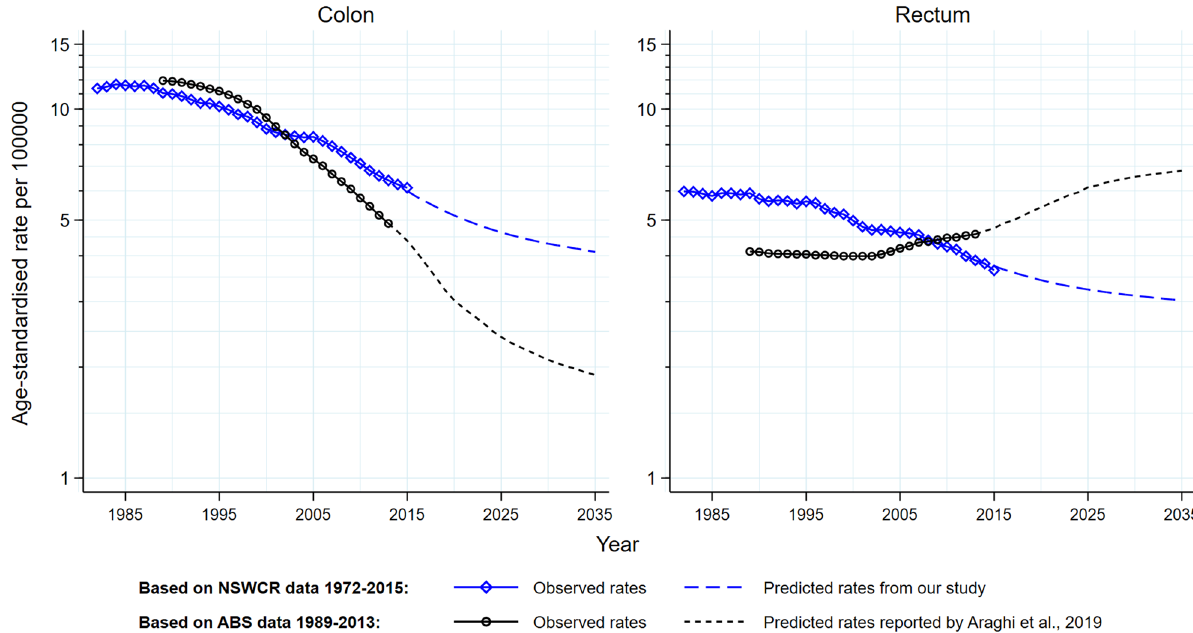
Figure 4. Comparison of projected age-standardised mortality rates published by Araghi et al. 2 , with the results from this study and observed rates based on data from the NSWCR for colon and rectal cancers, males and females combined. All rates are age-standardised using the Segi World standard population. NSWCR: New South Wales Cancer Registry. ABS: Australian Bureau of Statistics. Age-standardised rates from Araghi et al. 2 were extracted from the published table and figure (using online computer software WebPlotDigitizer which is available via https:// autom eris. io/ WebPl otDig itizer/). Reference: Araghi et al. 2